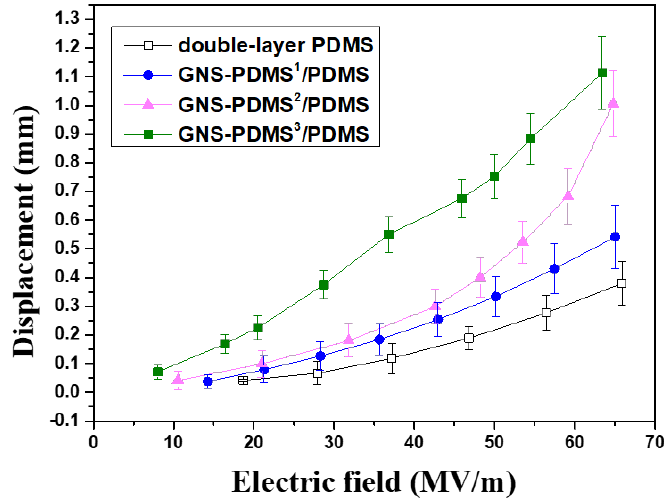
Figure 6. Displacement of the films as a function of electric field intensity